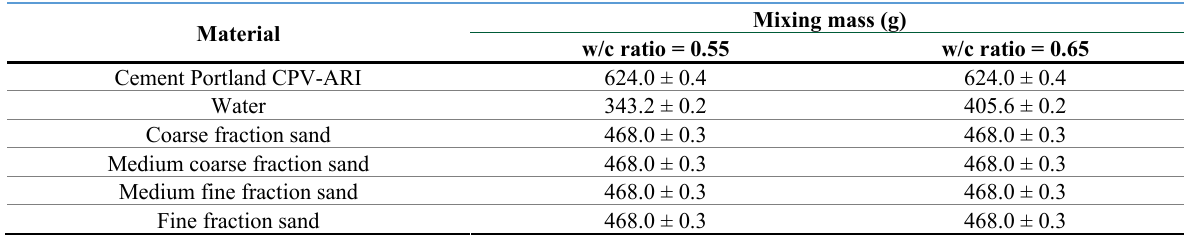
Table 3. Quantity of materials in each mixture.